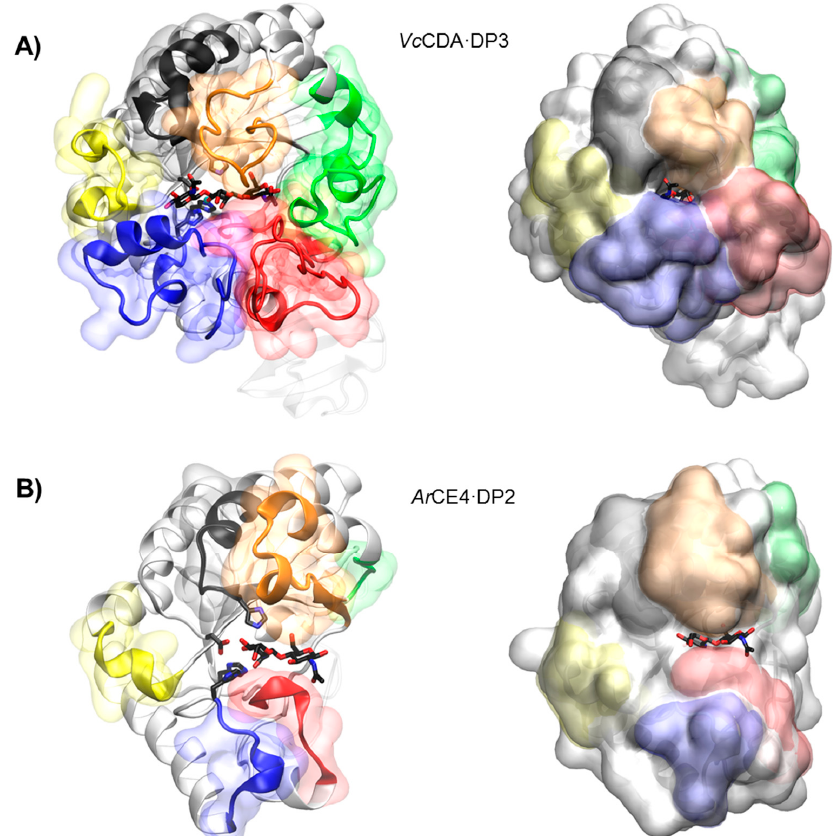
Figure 6. 3D structures of enzyme·substrate complex. ( A ) Vc CDA with DP3 substrate and ( B ) Ar CE with DP2 substrate. Loops 1 to 6 are colored as in Figure 3.